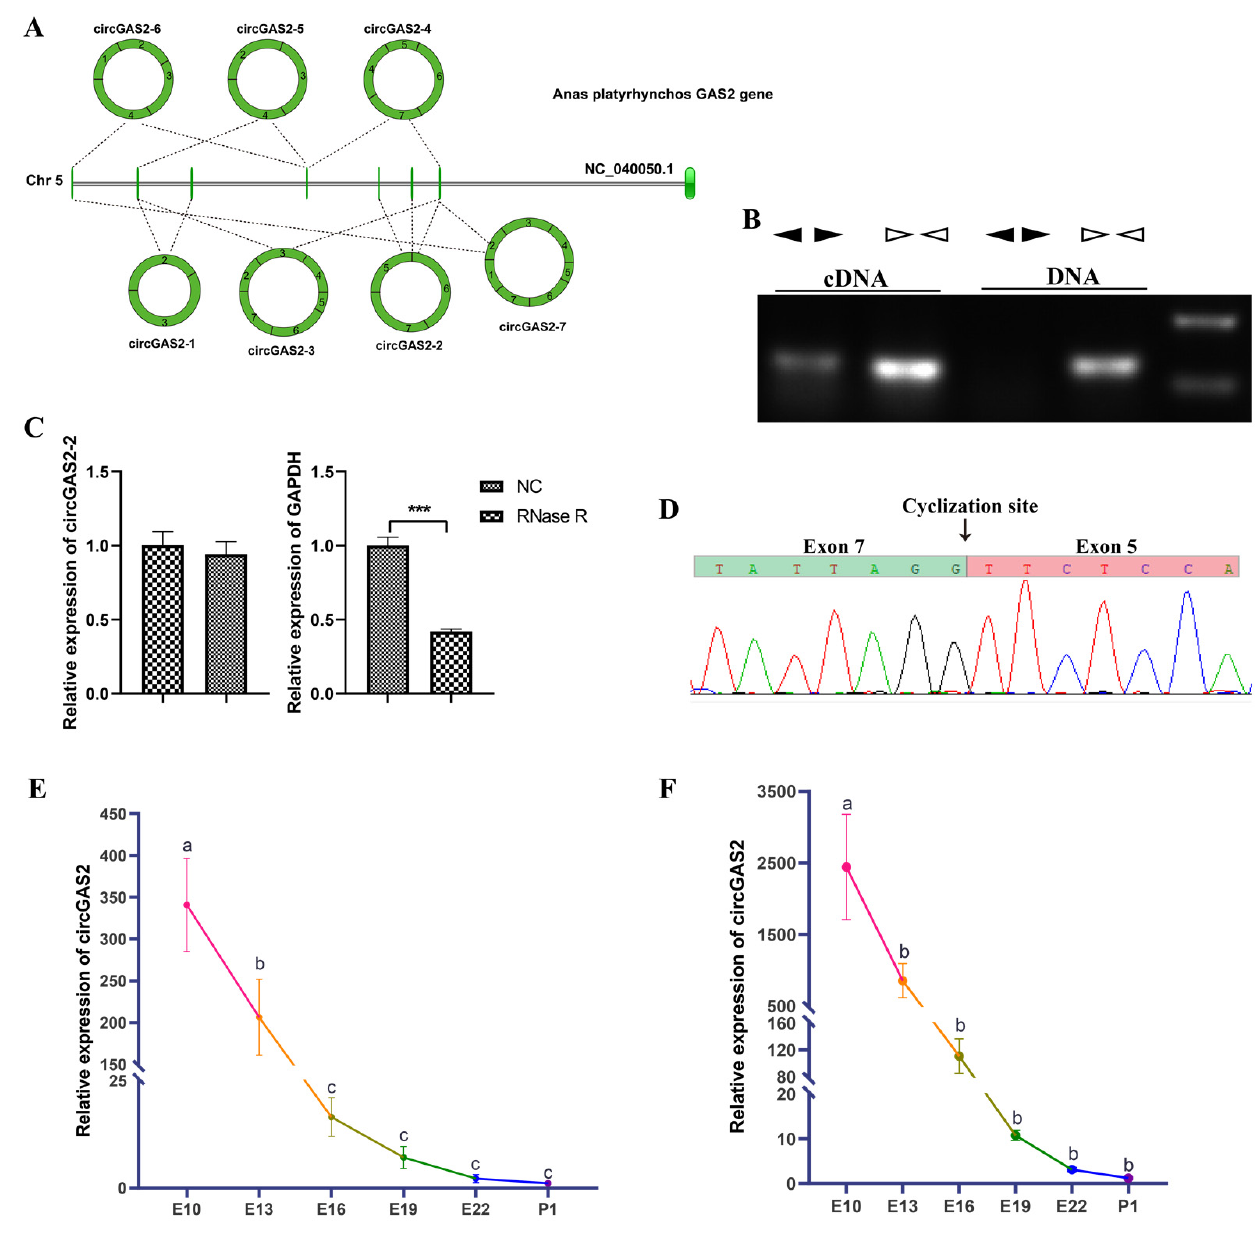
Figure 5. Validation and differential expression of circGAS2-2. ( A ) Scheme of the genomic structure and circular transcripts of GAS2 . The green rectangles and the green vertical lines represent the exons of GAS2 . The circular rings represent seven circRNAs derived from GAS2 . ( B ) A divergent primer set amplified the fragment of circGAS2-2 in cDNA but not in genomic DNA. The black triangles represent the divergent primers, and the white triangles represent the convergent primers. ( C ) qRT-PCR results showing that RNase R had no impact on circGAS2-2. ( D ) Sanger sequencing results confirming the junction sequence of circGAS2-2. ( E , F ) Spatiotemporal expression of circGAS2-2 from E10 to P1 in breast muscle and leg muscle, respectively. The values are shown as means ± SEM. *** p < 0.001. The different letters indicate significant differences between the two groups ( p < 0.05).